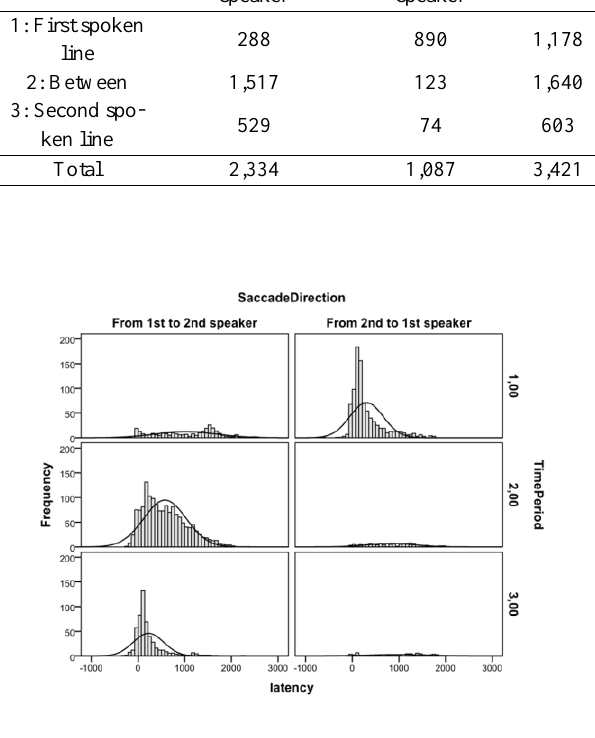
Figure 2. Histograms of saccadic latencies from 1 st to 2 nd (left panels) and from 2 nd to 1 st (right panels) speaker in each time